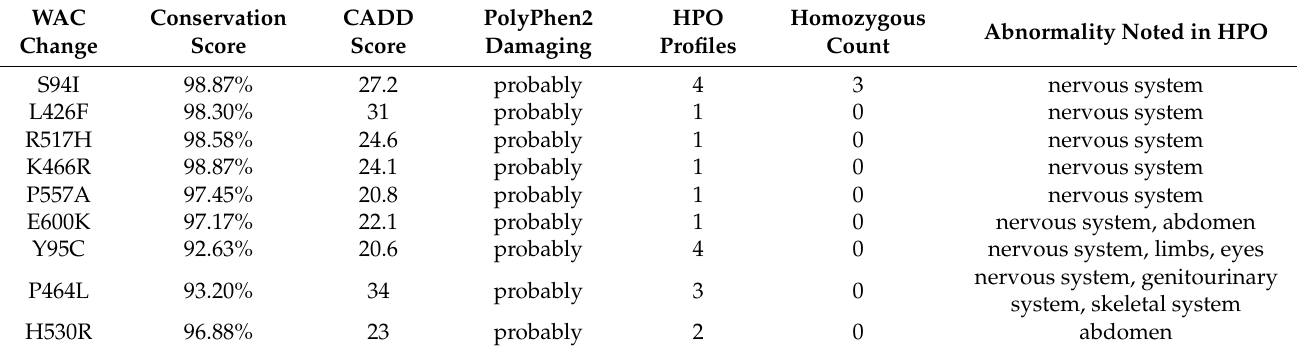
Figure 2. Predicted WAC protein structure. An AlphaFold protein model of WAC showing con- served amino acids colored as blue: polar basic; red: polar acidic; orange: S/T; cyan: all other conserved amino acids. Shown below are zoomed in view of several conserved motifs within WAC that fall within intrinsically disordered regions. Table 1. High ranking Geno2MP